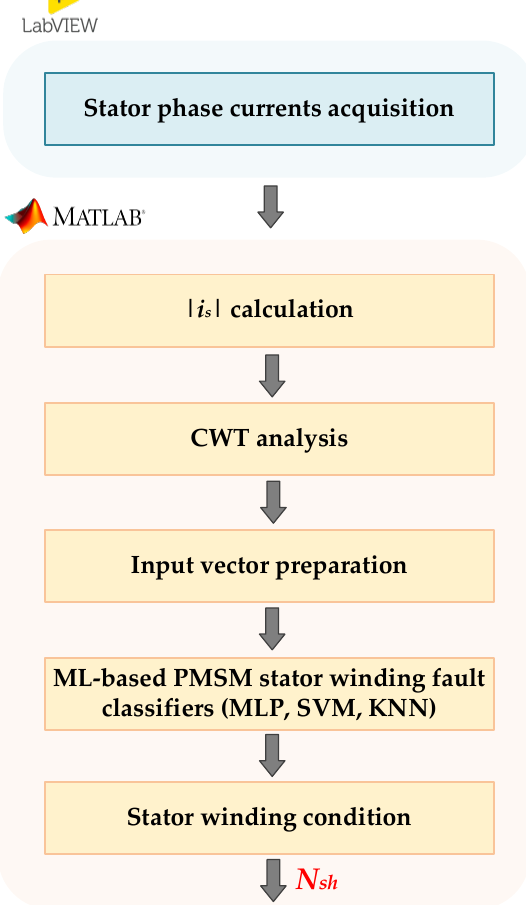
Figure 19. Block diagram of the proposed fault diagnosis method.